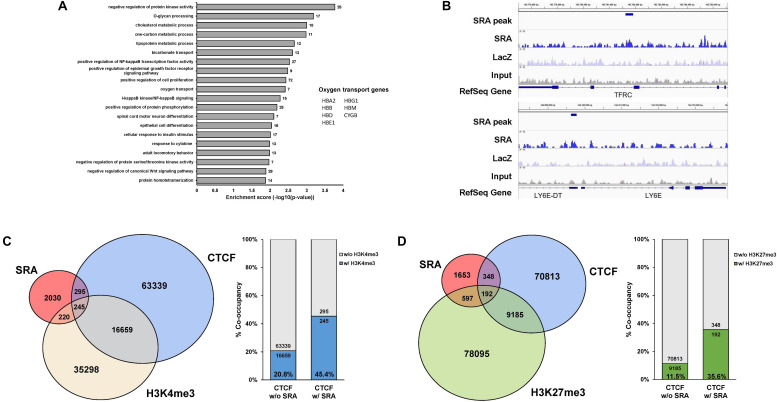
The lncRNA SRA occupies chromatin genome-wide with CTCF, H3K4me3, and H3K27me3. ChIRP-seq analysis of SRA was performed using human erythroblast cells K562. Publicly available ChIP-seq data for CTCF, H3K4me3, and H3K27me3 were derived from the ENCODE project. (A) Categories of enriched gene ontologies of SRA-associated genes (p-value < 0.05) and their enrichment scores [−log(p-value)] were analyzed using DAVID. (B) Examples of genes with the enrichment signal of SRA, LacZ, and the input. (C) Genomic regions occupied by SRA and containing CTCF binding site tend to associate with H3K4me3. Left; Genome-wide SRA-binding sites were compared with CTCF and H3K4me3. Right; Percentage of co-occupancy of H3K4me3 at SRA binding sites without or with CTCF occupancy. (D) Genomic regions occupied by SRA and containing CTCF binding site tend to associate with H3K27me3. Left; Genome-wide SRA-binding sites were compared with CTCF and H3K27me3. Right; Percentage of co-occupancy of H3K27me3 at SRA binding sites without or with CTCF occupancy.